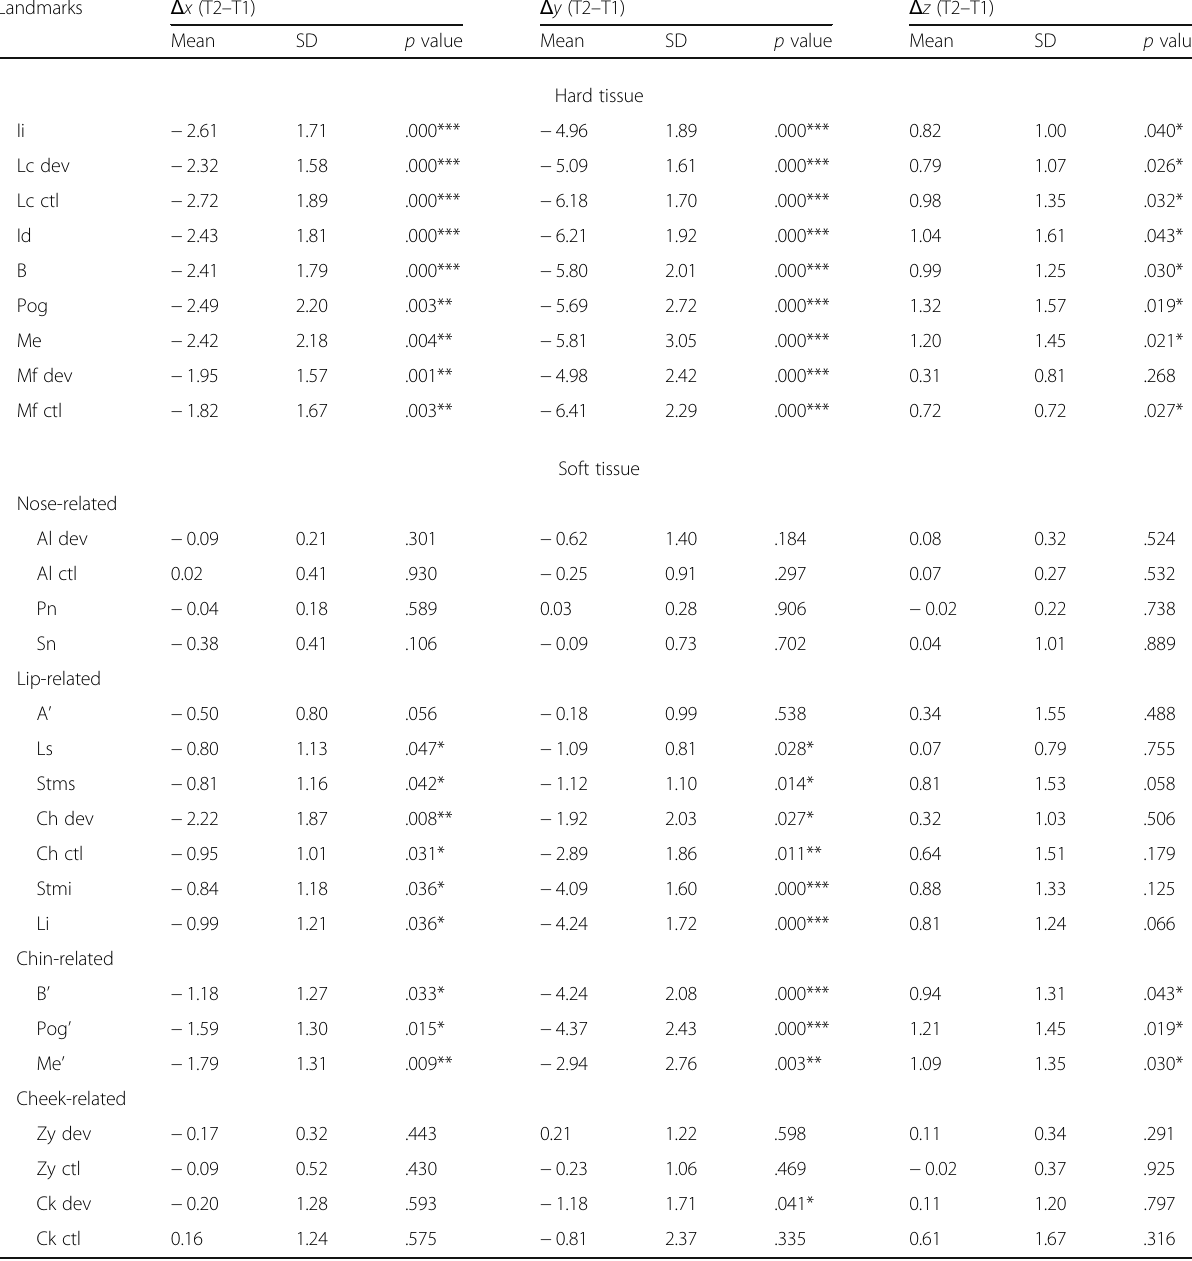
Table 4 Changes in hard tissue and soft tissue landmarks on CBCT images